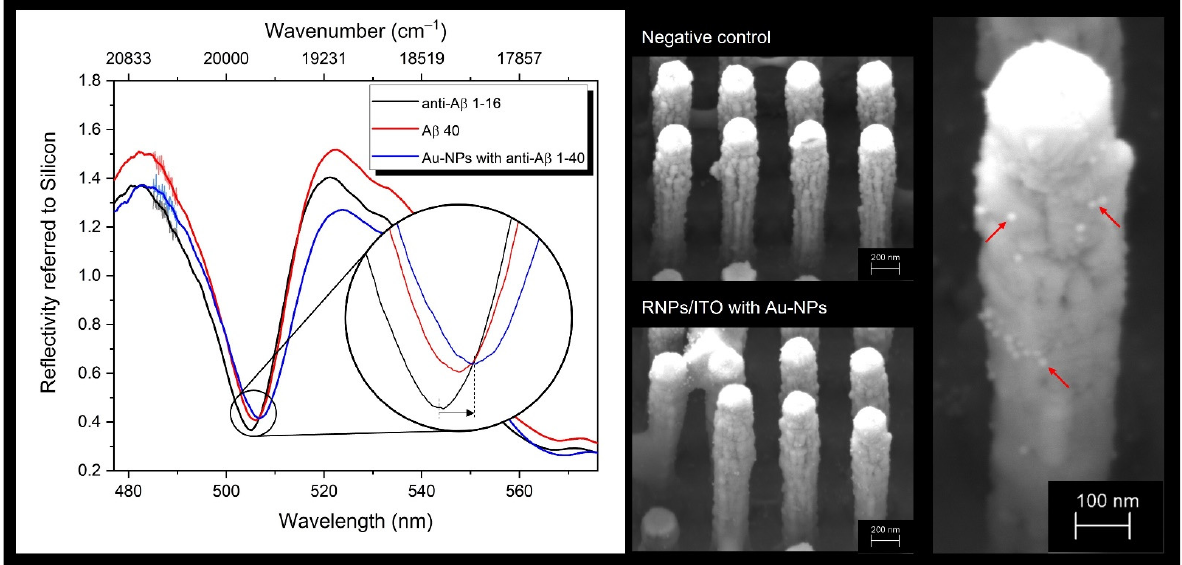
Figure 6. ( left ) Biological detection reflectivity spectra of R-NPs/ITO for capture antibody immobi- lization (black), peptide deposition (red) and antibody recognition enhanced with Au-NPs (blue). ( right ) SEM images of R-NPs/ITO after Au-NPs deposition, along with negative control (see Figure S6); Au-NPs are highlighted by red arrows in the expanded image on the right.